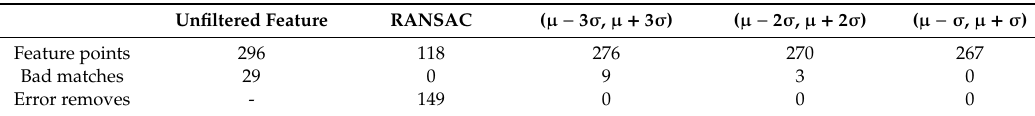
Table 2. The statistics of the outliers with di ff erent methods for case 2.